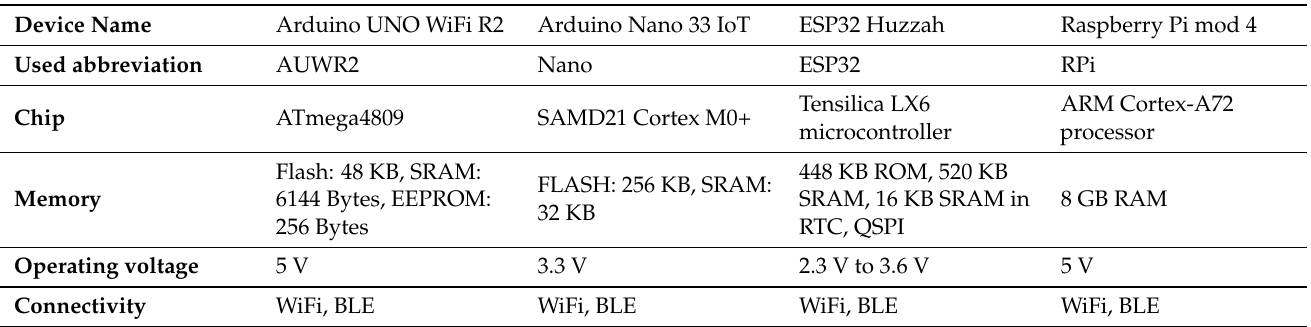
Figure 3. The proposed middleware architecture for Smart Environment and IoT cybersecurity (*-MQTT) Table 1. Hardware platforms